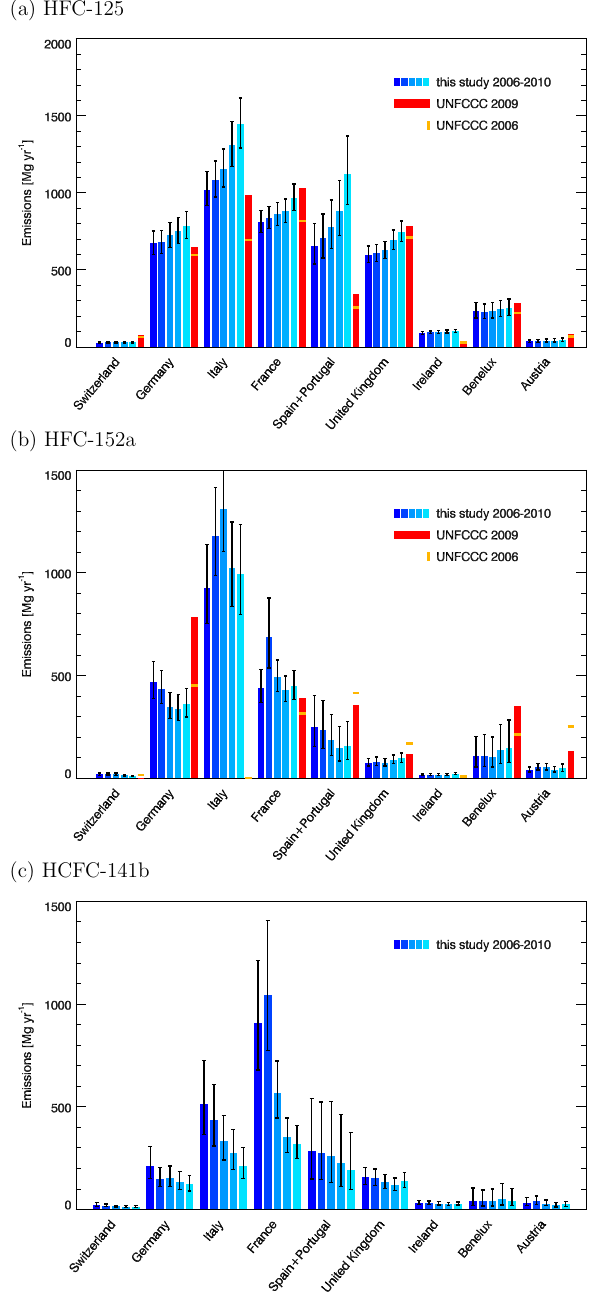
Fig. 11. Evolution of country-specific annual mean emissions of (a) HFC-125, (b) HFC-152a, and (c) HCFC-141b from 2006 to 2009. Blue columns are a posteriori emissions and corresponding 1 σ un- certainties. Red columns correspond to national emissions reported to UNFCCC for the year 2009. Orange bars are corresponding val- ues for 2006. Reported values are based on National Inventory Sub- missions 2011 available online at